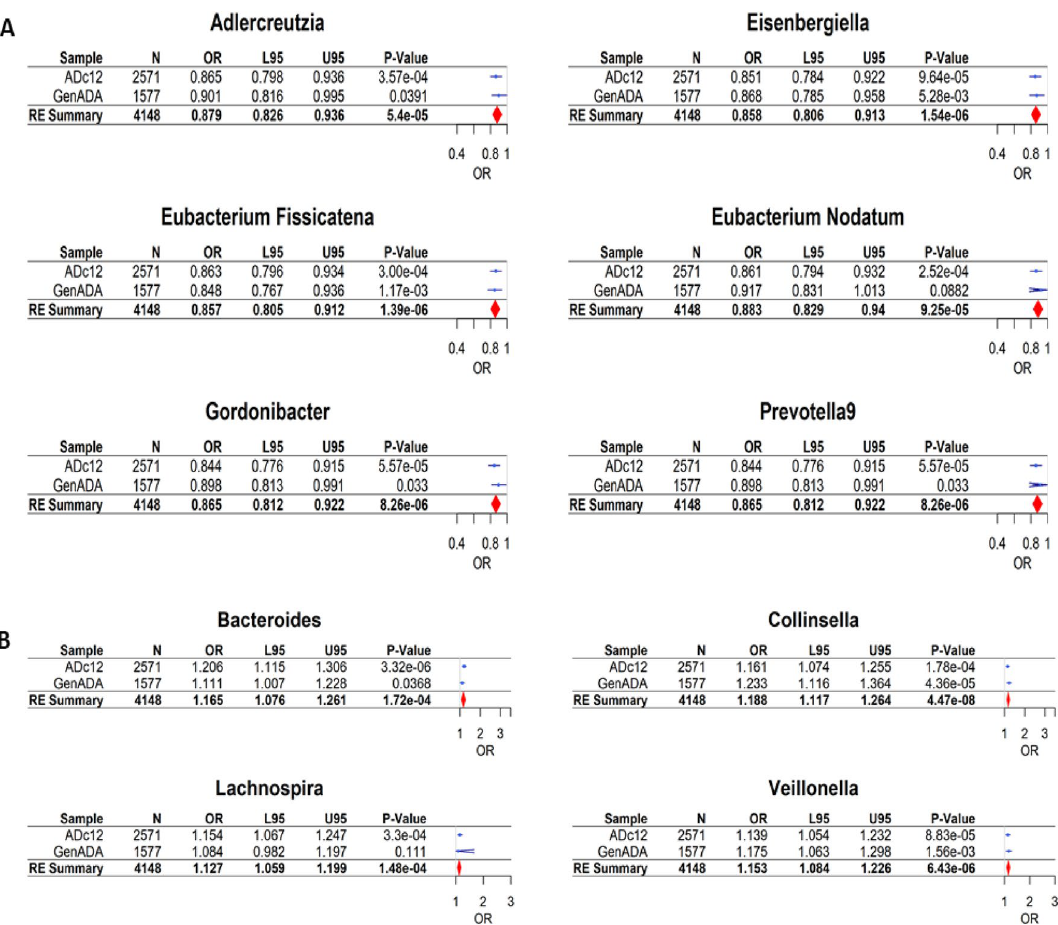
Figure 2. Forest plots of ten genera significantly associated with AD from meta-analysis. ( A ) The genetically predicted abundance of six genera showed significant association ( p < 0.00042) with AD diagnosis as a protective factor with ORs < 1.0. ( B ) Conversely, four genera showed significant association with AD as a risk factor with ORs > 1.0. OR (95%CI): Odds ratio of the respective genus with the lower and upper 95% confidence